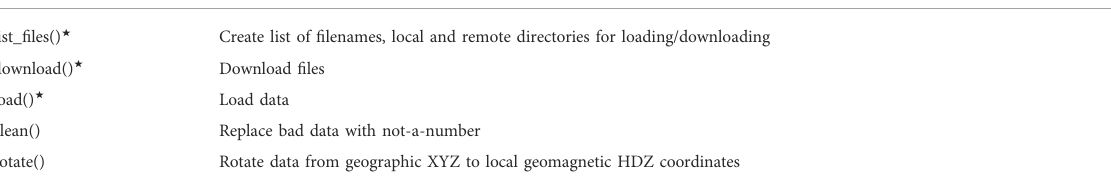
TABLE 2 List of function available for each of the arrays module. * function part of the THEMIS module. Functions